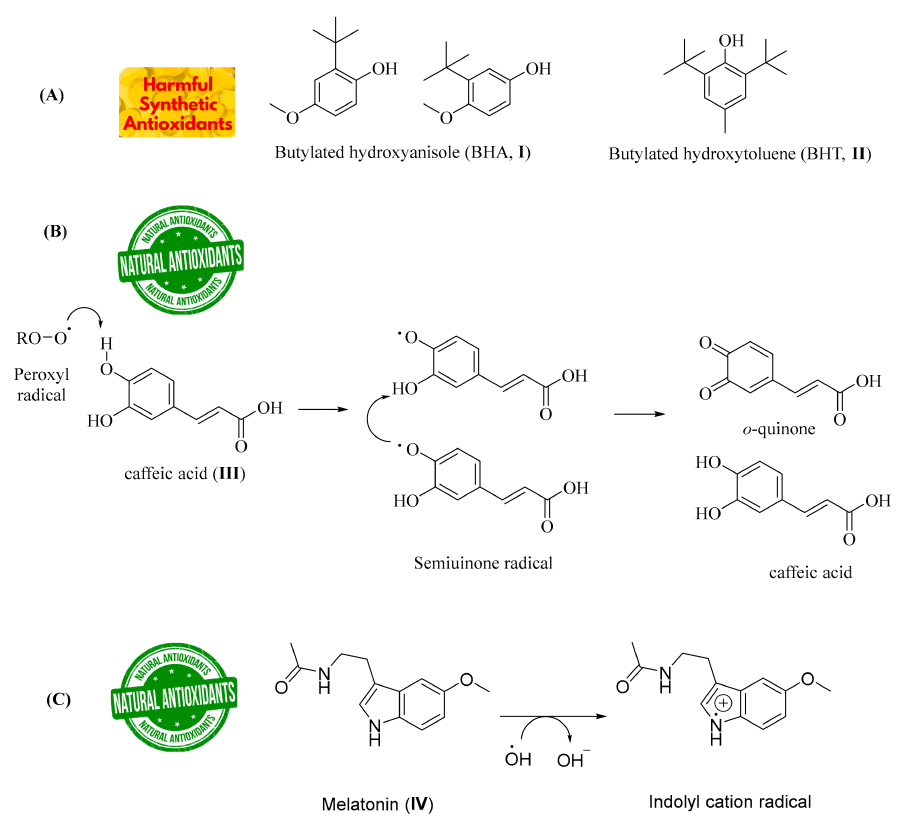
Figure 1. ( A ) Chemical structures of some well-known synthetic antioxidants (BHA; I and BHT; II) ; ( B ) Chemical structure of the natural antioxidant caffeic acid ( III ) and a proposed mechanism for caffeic acid antioxidant activity; ( C ) Chemical structure of the natural antioxidant melatonin ( IV ) and the proposed mechanism of how the electron-rich aromatic indole ring system of melatonin scavenges the hydroxyl radical (HO •